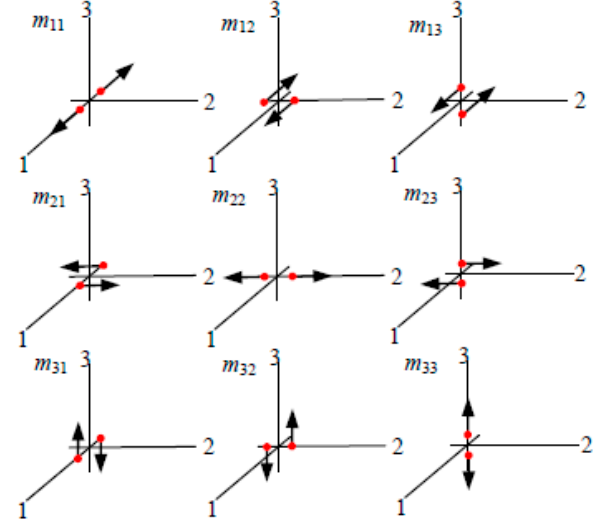
Figure 2. The secondary moment tensor components sketch map, m ij is the double couple ( i = 1, 2, 3; j = 1, 2, 3).